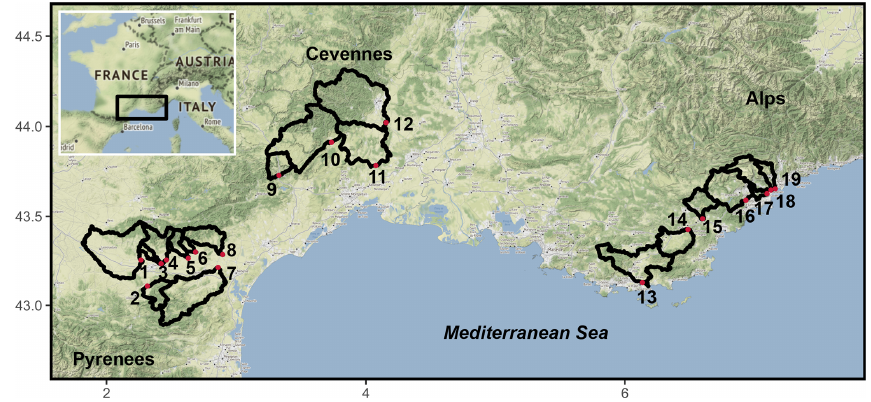
Figure 1. The black rectangle indicates the study area in France. The thick lines delineate the studied watersheds within this zone. The red circles correspond to the associated outlets. The base map used in the background was plotted in R with ggmap (Kahle and Wickham, 2013) and © Stamen Maps.